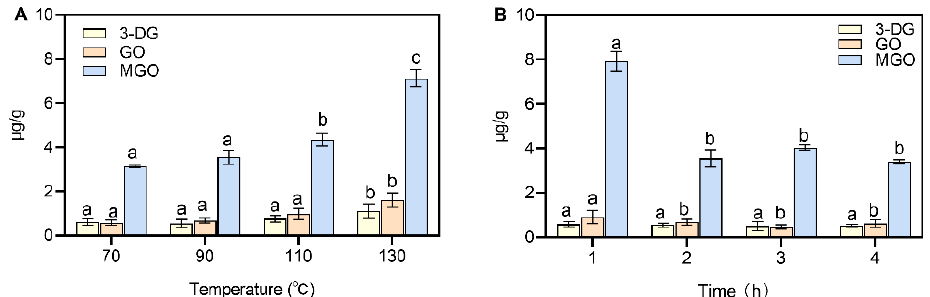
Figure 2. Effect of processing temperature and time on α -dicarbonyl compounds. ( A ) temperature; ( B ) time. Different letters above the bars indicate significant differences (n = 3, p < 0.05). Methylglyoxal (MGO), glyoxal (GO) and 3-deoxyglucuronide (3-DG).